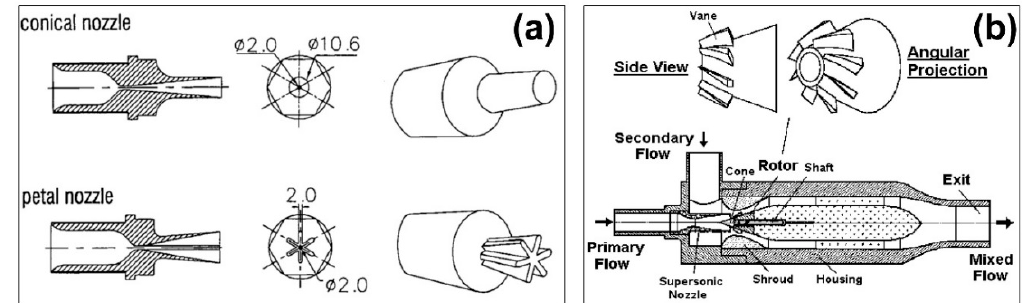
Figure 6. Primary nozzle variants: ( a ) petal nozzle [25]; ( b ) spinning rotor [29].